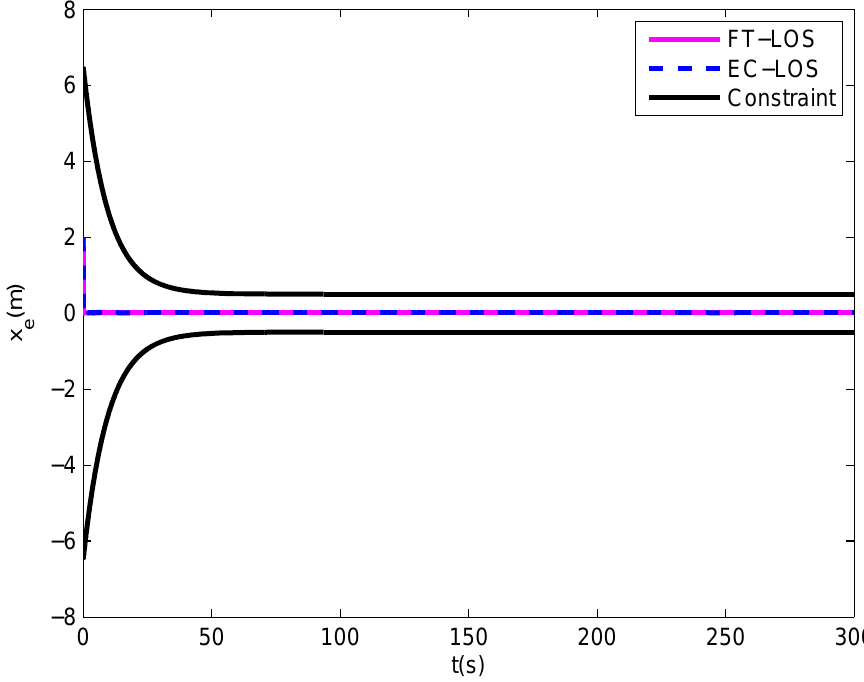
Figure 6. Along-track error of the underactuated MSV by different guidance laws.